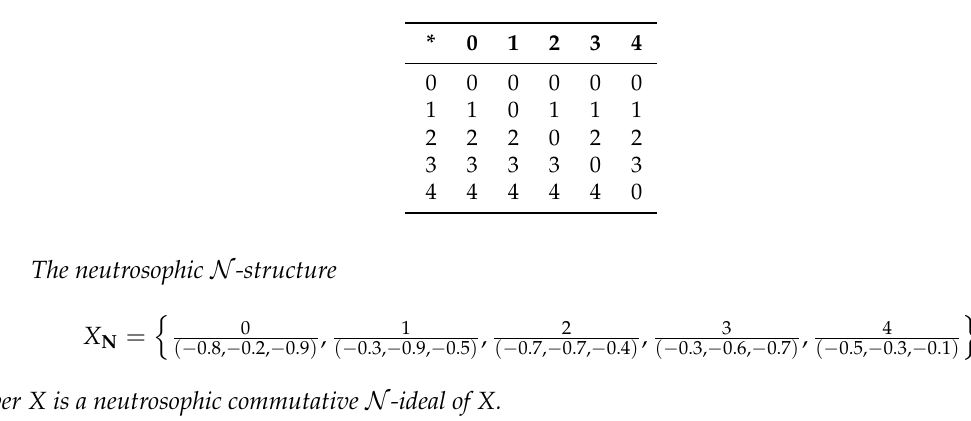
Table 1. Cayley table for the binary operation